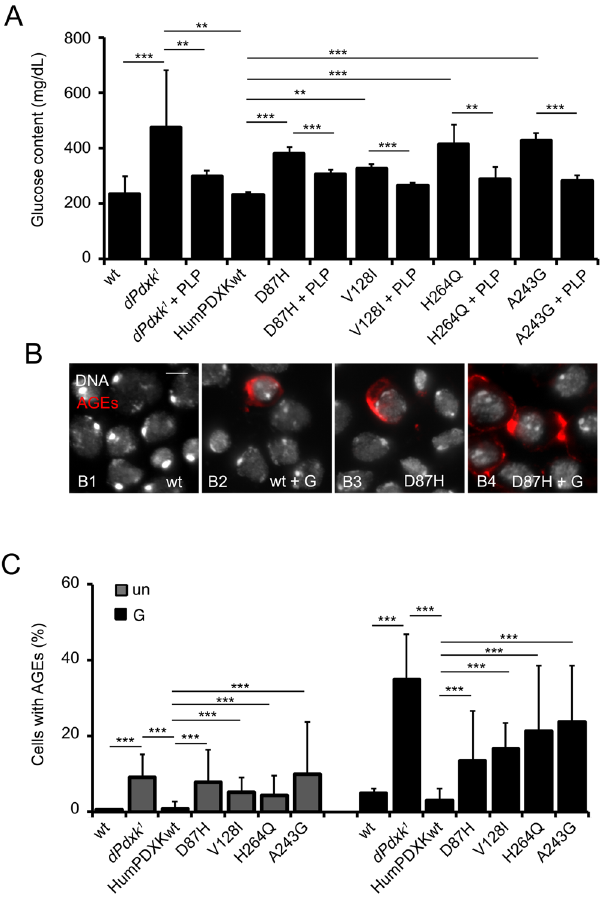
Figure 3. Human PDXK variants expressed in dPdxk 1 flies do not rescue hyperglycemia. (A) Glucose content in hemolymph from larvae expressing either wild type or PDXK variants, reared on standard medium with or without PLP (1 mM) supplementation. Columns are the means of 5 independent sample measurements ± SD (each sample = hemolymph extracted from 20 larvae). ** , *** Significantly different in the Student’s t test with p < 0.01 and < 0.001 respectively. (B) Examples of neuroblasts from untreated and 1% glucose treated brains expressing wt and D87H PDXK stained with an anti-human AGE antibody. Scale Bar 5 μ m. G = glucose (C) Frequencies of AGE-positive cells in brains untreated (un) and exposed to 1% glucose (G). Bars in the graph represent the mean frequencies of AGE-positive cells ( ± SD) in three independent experiments by scoring at least 1000 cells in 4 brains. *** Significantly different in the Student’s t test with p <